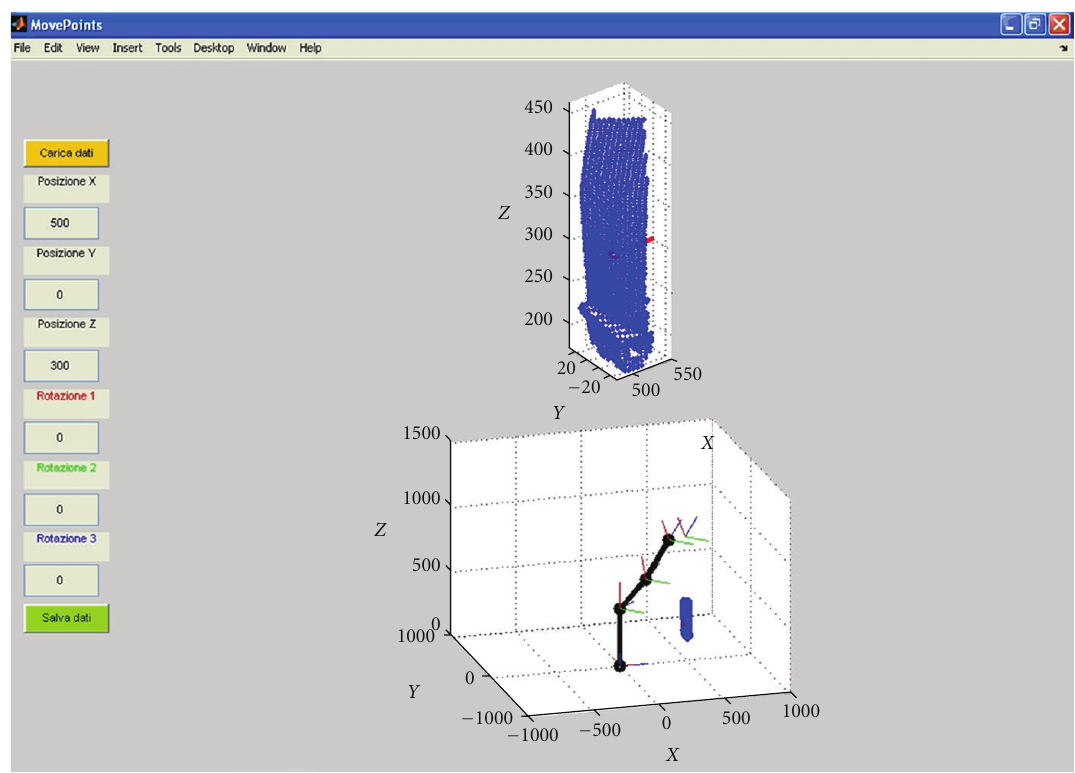
Figure 9: Graphical user interface to move and orient the acquired or cleared cloud of points.